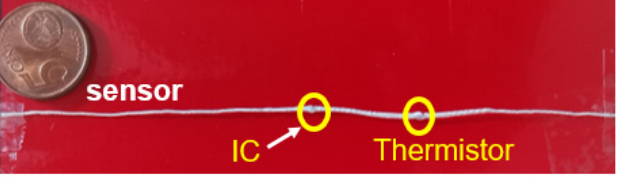
Figure 3. Fabricated temperature sensor tag using E-Thread technology.